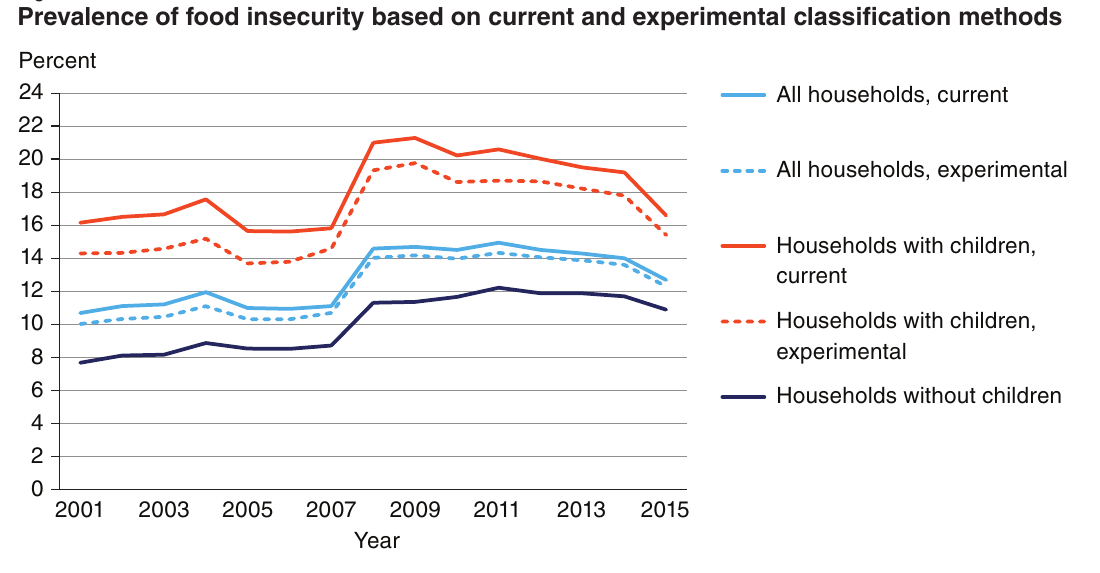
Prevalence of food insecurity based on current and experimental classification methods